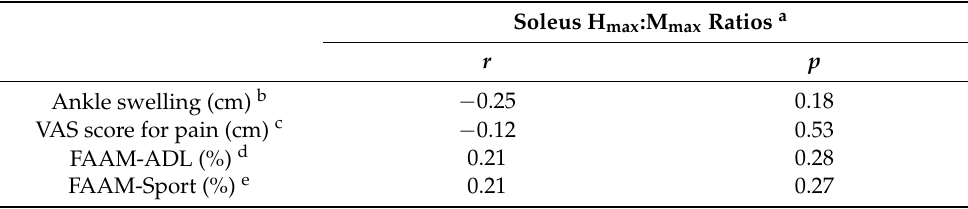
Table 3. Relationships between reduced spinal reflex excitability of soleus and acute